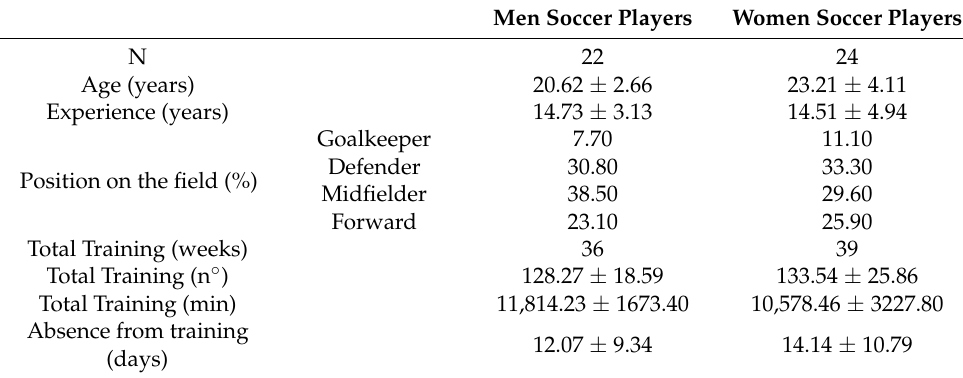
Table 1. Characteristics of soccer players.